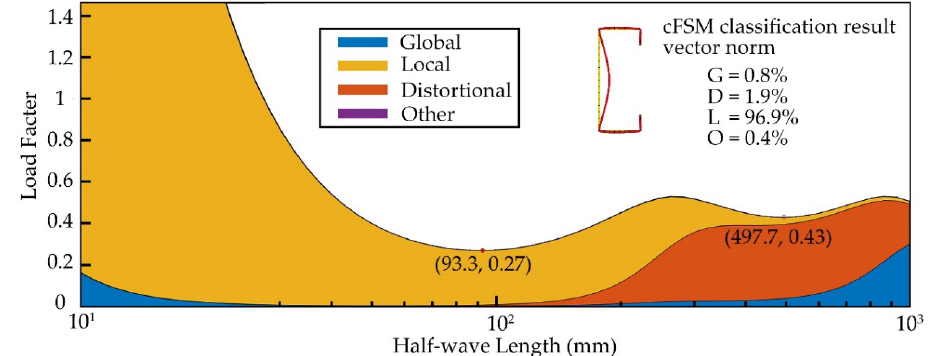
Figure 4. Buckling mode distribution of single member in elastic critical state (member is No.1 cross-section, 2 mm thick, 600 mm long).